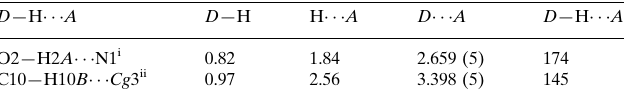
Hydrogen-bond geometry (A˚ , (cid:2)